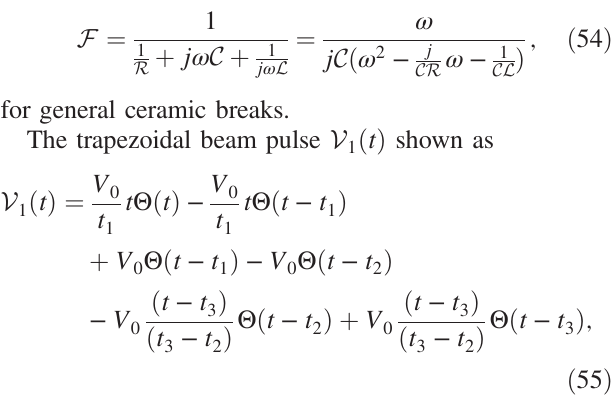
ð thr Þ ð thr Þ 11 ; S 12 ),